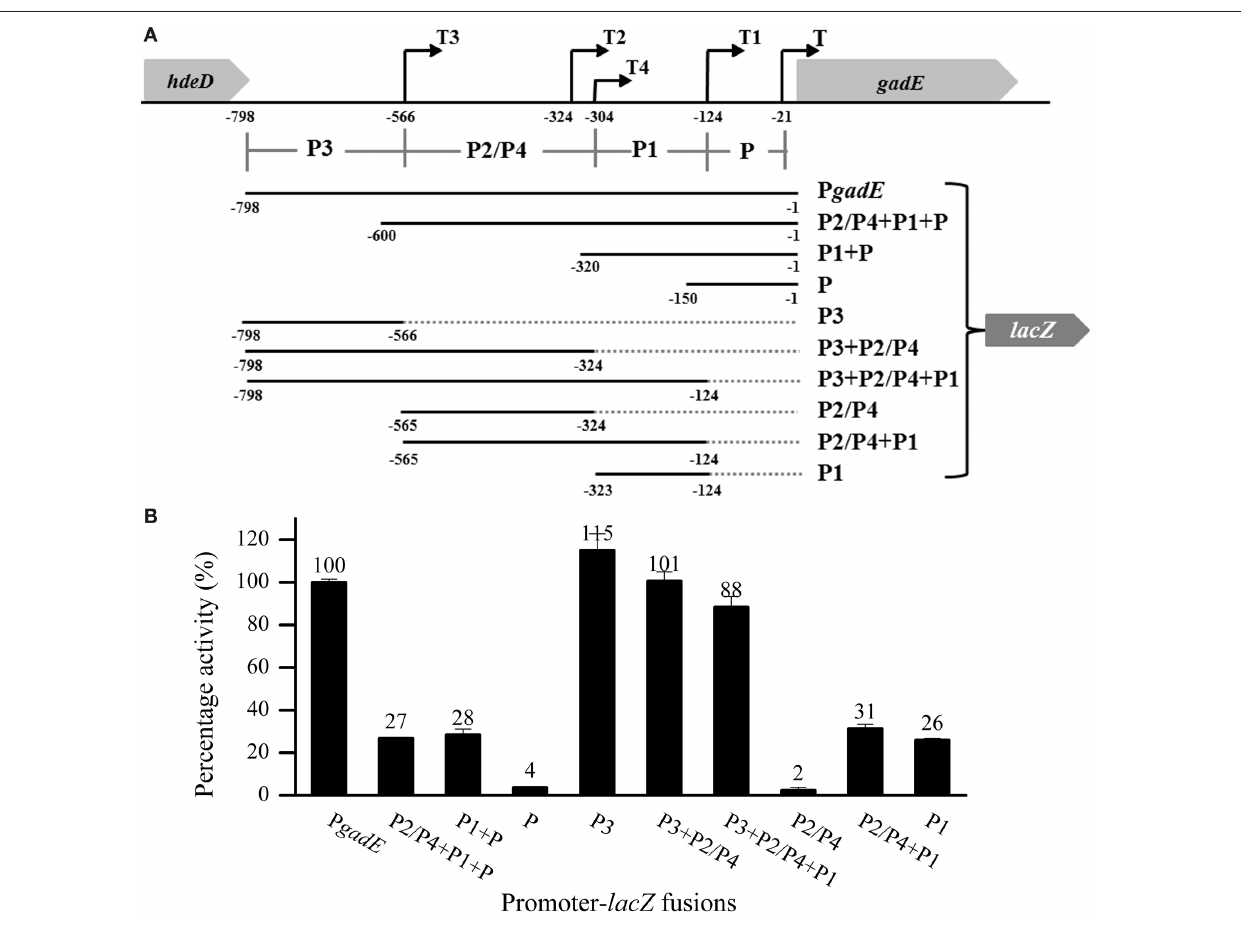
FIGURE 1 | The P3 region is important in the anaerobic up-regulation of gadE-mdtEF . (A) Schematic diagram of the constructed promoter- lacZ fusions. P gadE is defined as the 798bp intergenic region between the hdeD and gadE genes. Labeled numbers indicate the nucleotides positions relative to the ATG start codon of gadE . Transcription starting sites are indicated as black arrows, and the regions upstream of each of the transcription starting sites are